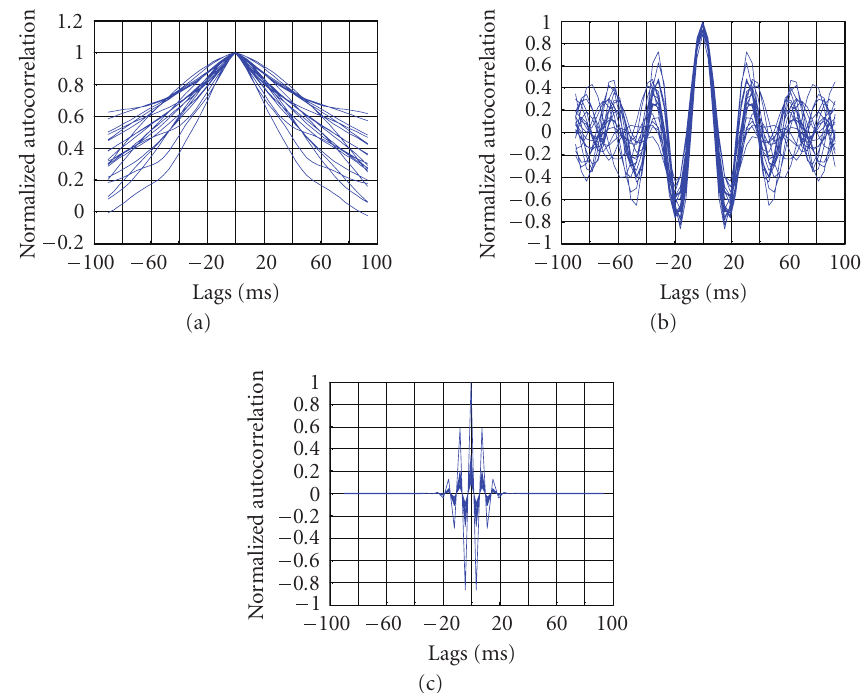
Figure 5.1 . (a) The autocorrelation of the EEG colored noise, (b) autocorrelation of the EEG colored noise whitened by AR Yule-Walker, (c) autocorrelation of the EEG colored noise whitened by AR-